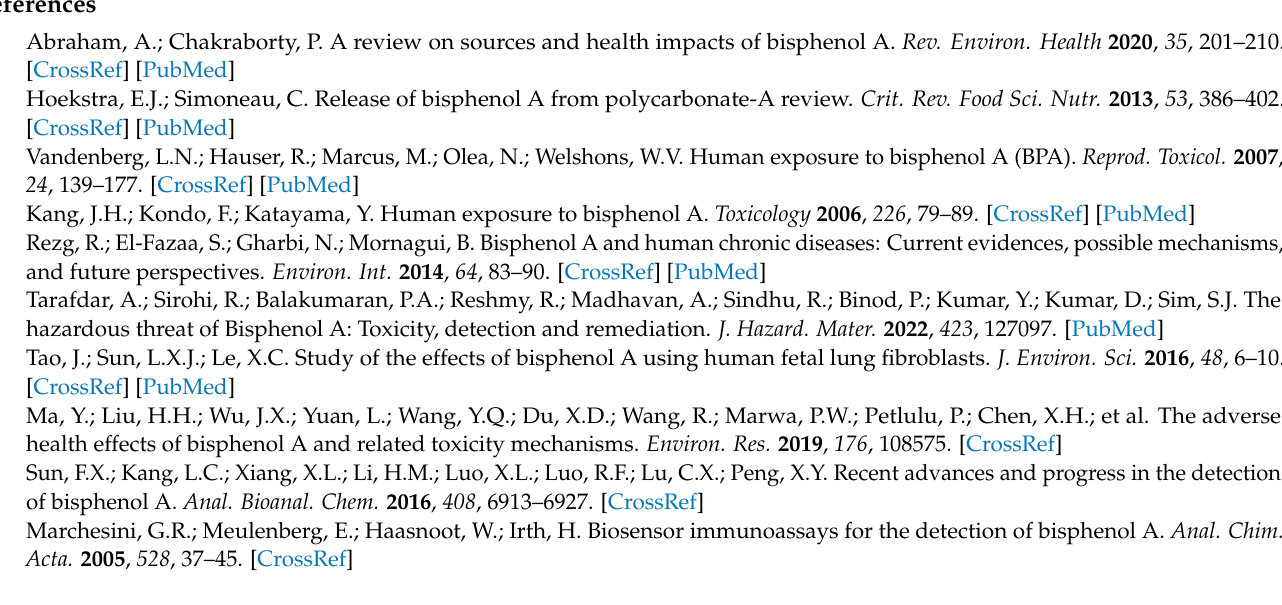
5-fold diluted bottle water; Table S1: Summary of binding affinity of mutated BP33 probes; Table S2: Sequences of aptamers for fabrication of electrochemical sensors; Table S3: A comparison of some electrochemical aptasensors for